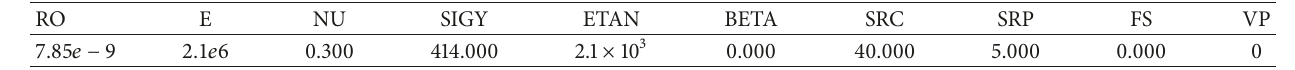
Table 3: Corresponding information of MAT_PLASTIC_KINEMATIC.